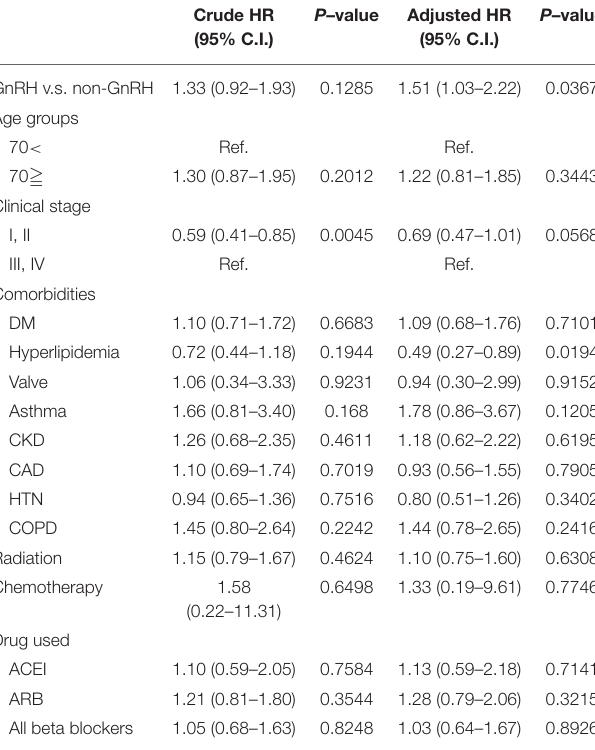
TABLE 2 | Risk factors of 5 years venous thromboembolic events (VTEs) between prostate cancer patients with or without gonadotropin-releasing hormone therapy (GnRH). P -value Non-GnRH GnRH N = 5,420 N = 5,420 Crude HR Adjusted HR (95% C.I.) (95% C.I.)